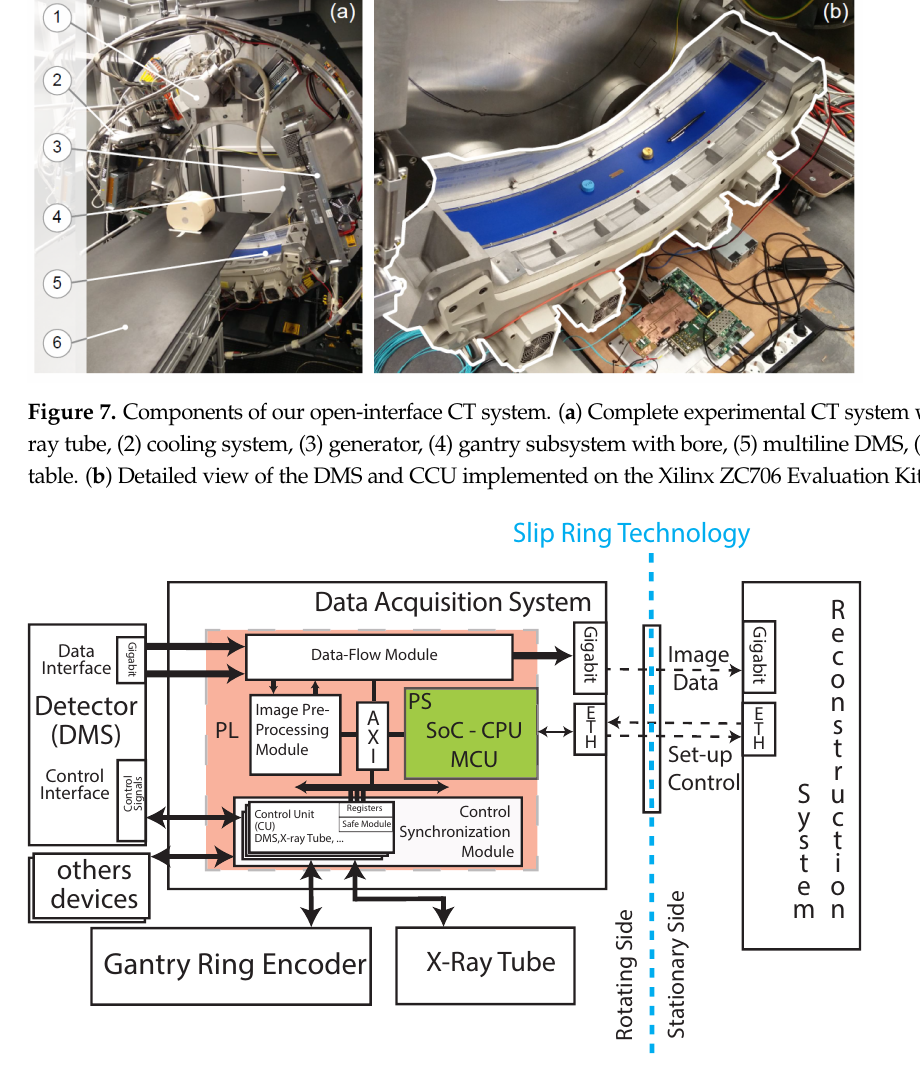
Figure 8. System architecture of the open-interface CT, Reprinted with permission from Ref. [41]. Copyright 2020,